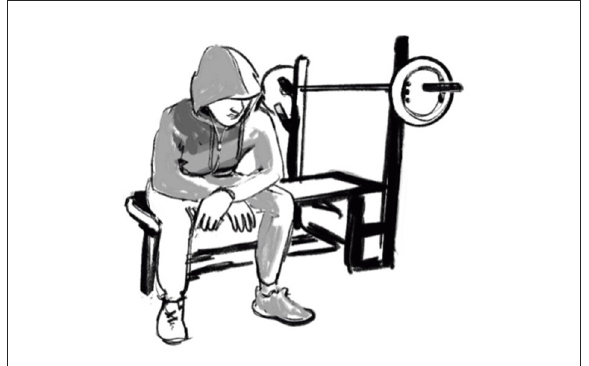
FIGURE2 Alone at the gym. Illustrated by Jenny